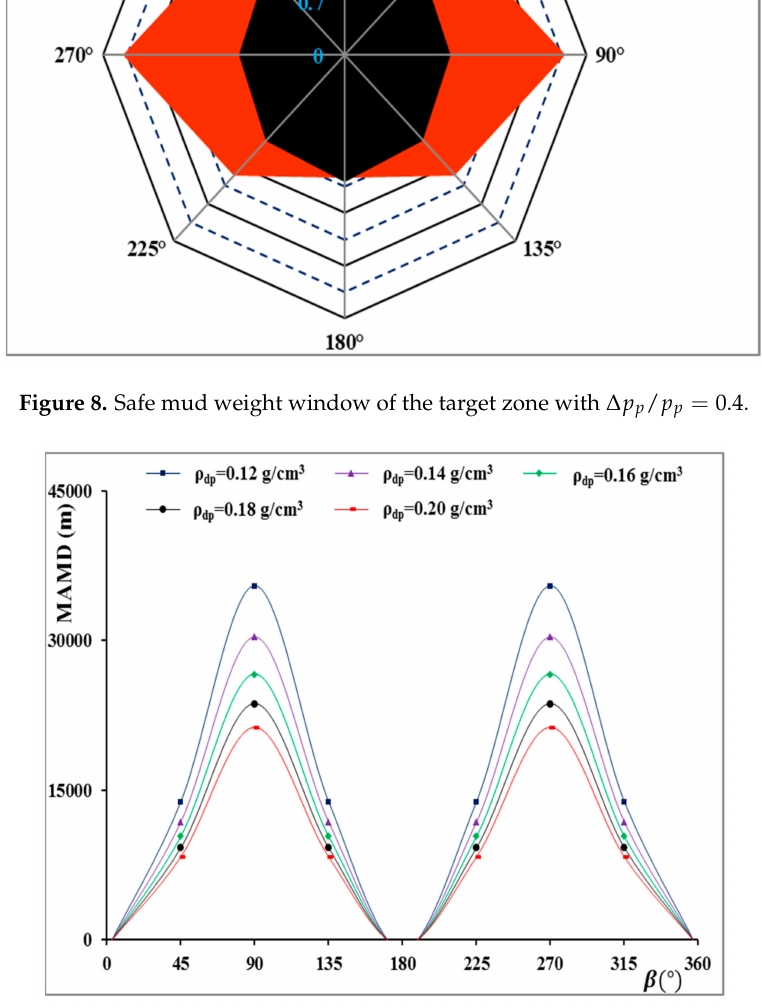
Figure 9. MAMD with ∆ p p / p p =